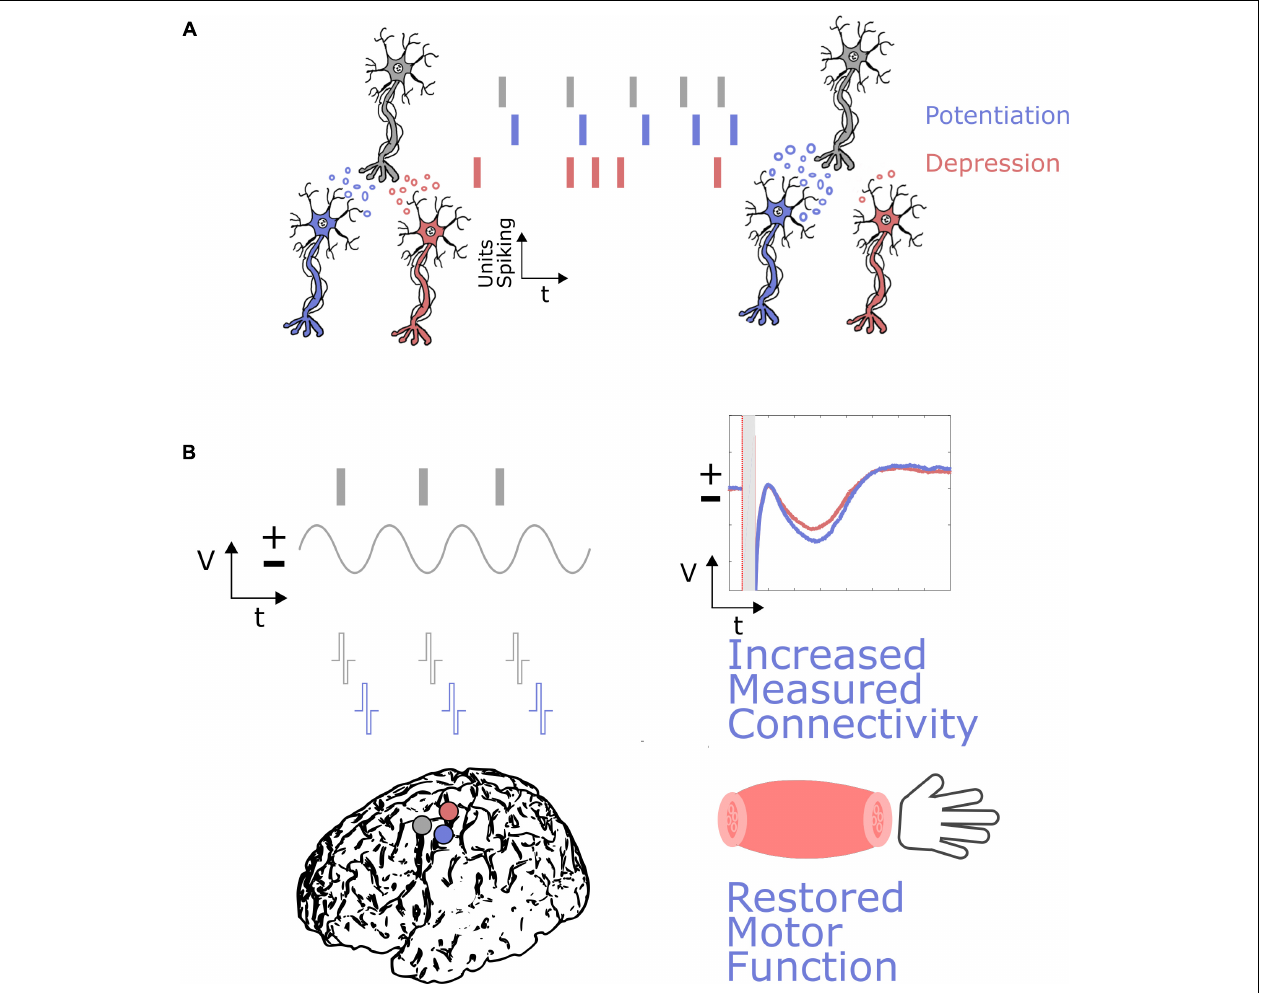
FIGURE 3 | Neural plasticity induction through neuromodulation via DES in ECoG-BCIs. (A) The basic principles of neural plasticity involve the timing of activity between neurons resulting in the strengthening of connections, where potentiation occurs if the neurons fire with the appropriate timing in a causal manner, and depression occurs if neurons do not fire with the appropriate timing. (B) These principles could be used for neuromodulation through DES and ECoG-BCIs by stimulating near a particular damaged cortical region (purple), based on activity at a spared cortical region (gray). This activity could be a marker of neuronal firing, or a local field potential representing when neurons are more likely to be firing synchronously. Appropriately timed stimulation could then result in increased connectivity, measured through markers such as evoked potentials, and restored motor function relative to baseline. A damaged region not undergoing neuromodulation is shown in red, where evoked potentials are not positively modulated and motor function is not